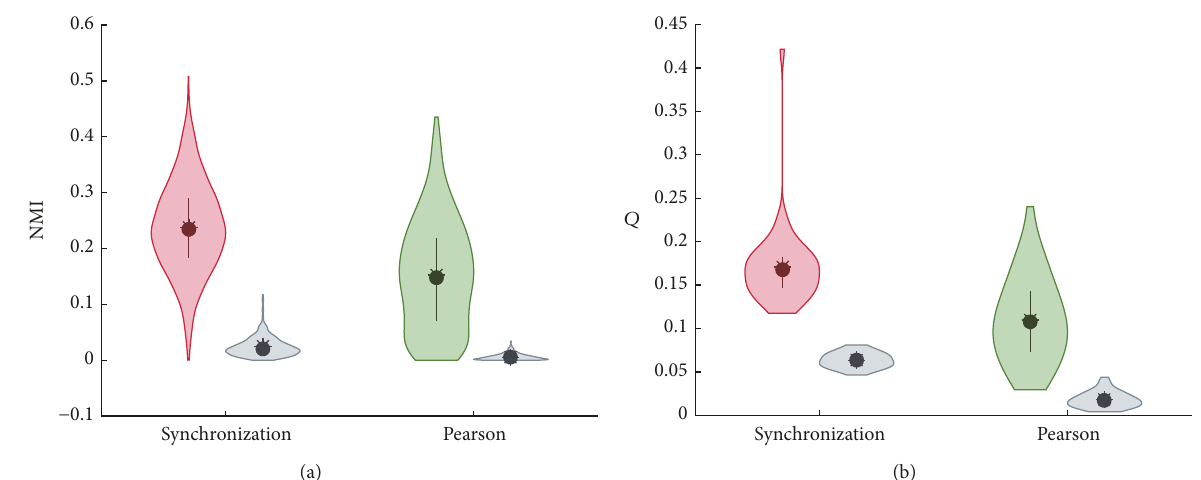
Figure 2: Violin plots of (a) within-group NMI distributions and (b) 𝑄 distributions for synchronization and Pearson’s correlation connectivity metrics with their randomized matching networks (in